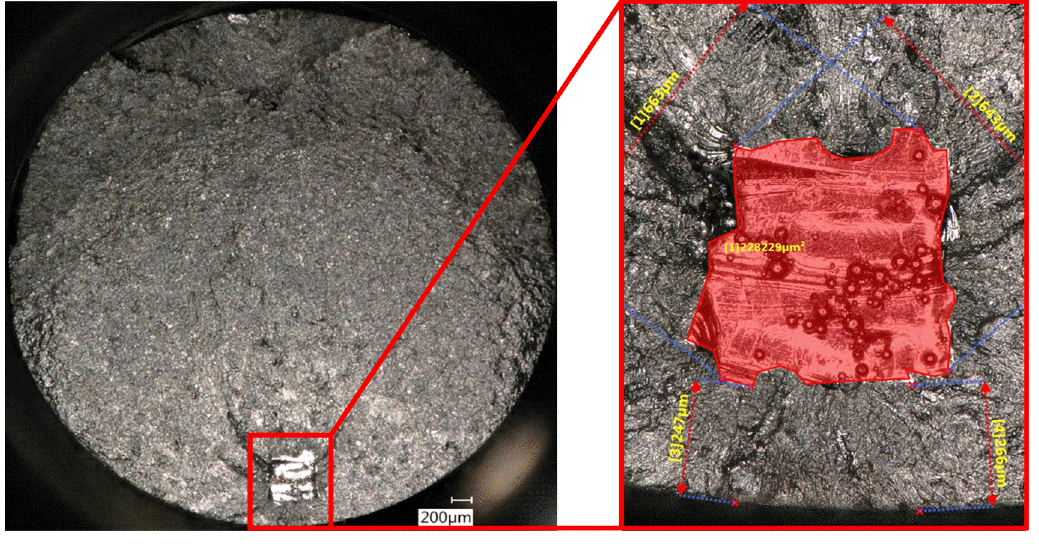
Figure 12. Defect area determination through fractographic